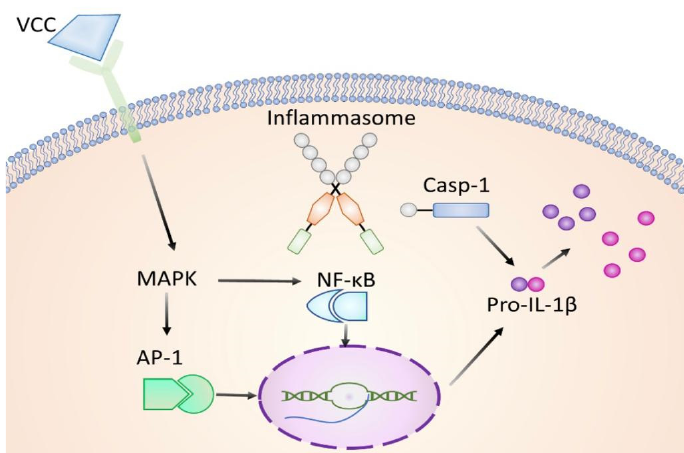
Figure 8. Model mechanism proposed for the monomeric VCC starting the innate immune response. The monomeric form of the VCC behaves as a PAMP; it binds its membrane receptor (TLR 4), turning on a signaling cascade activating MAPKs (ERK, p38 and perhaps JNK). The MAPKs then start the activation of the transcription factors AP ‐ 1 and NF ‐κ B, starting the pro ‐ inflammatory and innate response involved with the synthesis of the classic IL ‐ 1 β .